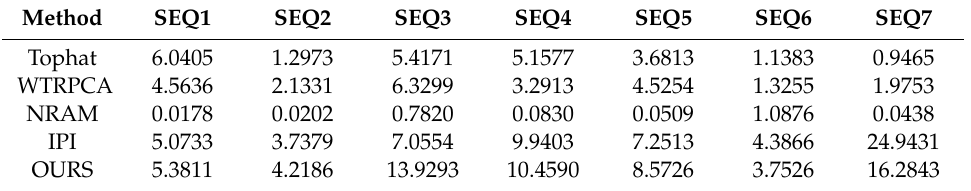
Table 3. The signal clutter ratio gain (SCRG) values of representative sequences. Table 3 . The signal clutter ratio gain (SCRG) values of representative sequences.